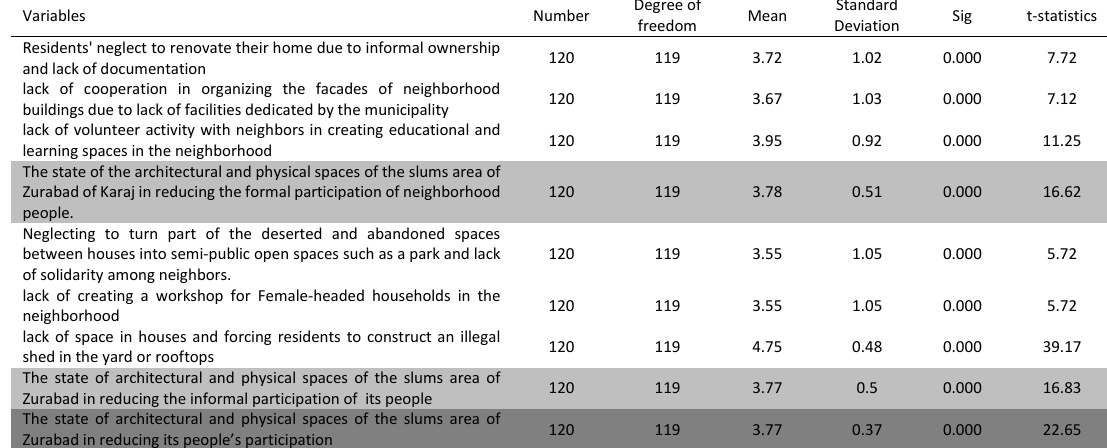
Table 7. Test results for the current state of the physical and architectural spaces of the slums area of Zurabad of Karaj in reducing the neighborhood’s people’s participation Variables